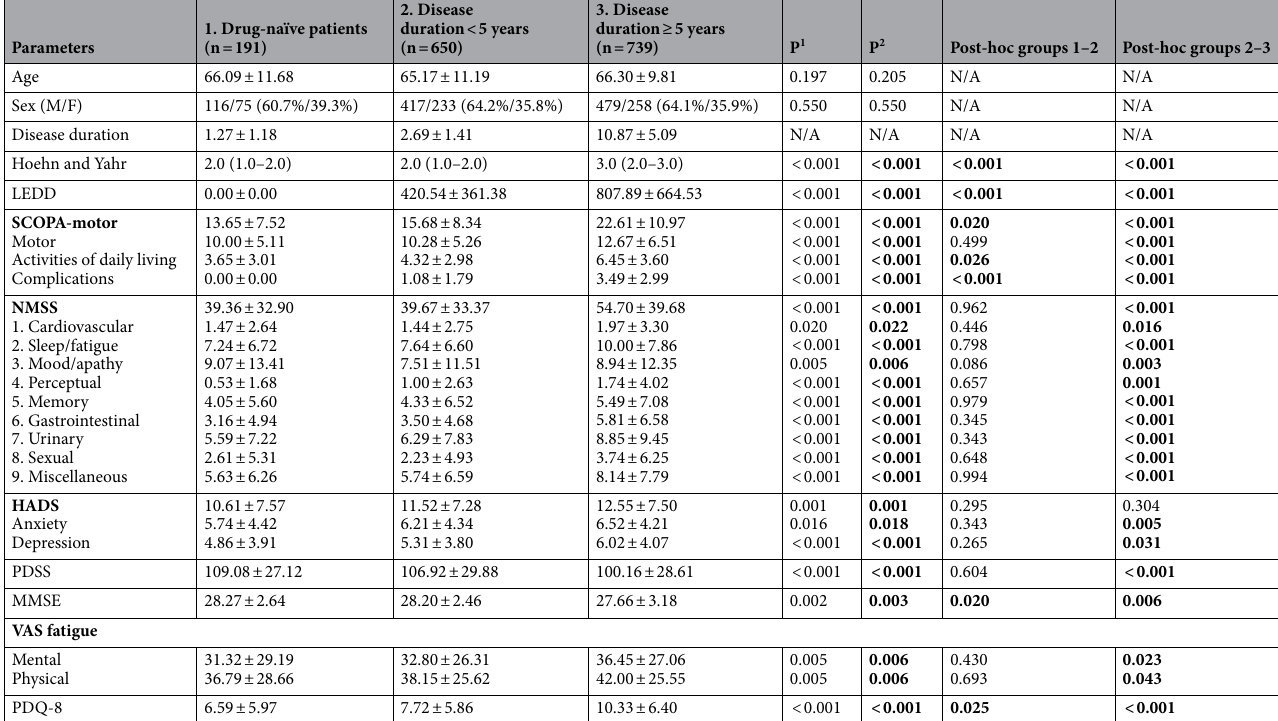
Table 2. Non-motor burden and profile differences between drug-naïve and medicated participants with Parkinson’s disease. Data presented as mean ± standard deviation, except for Hoehn and Yahr stage